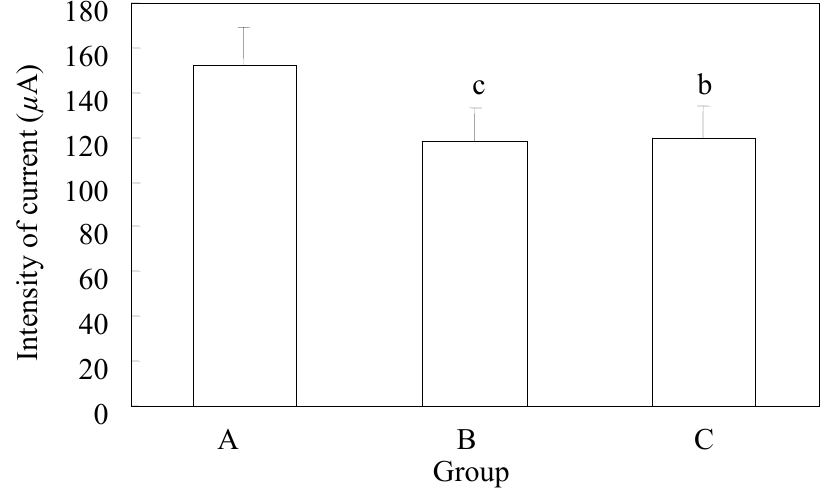
A - control group; B - application of EGb 761 in the experiment began five